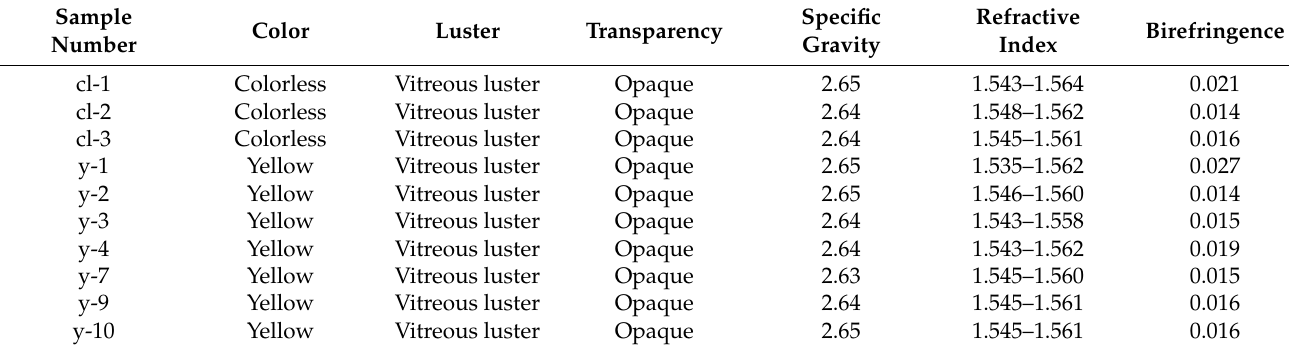
Table 1. Conventional gemological properties of